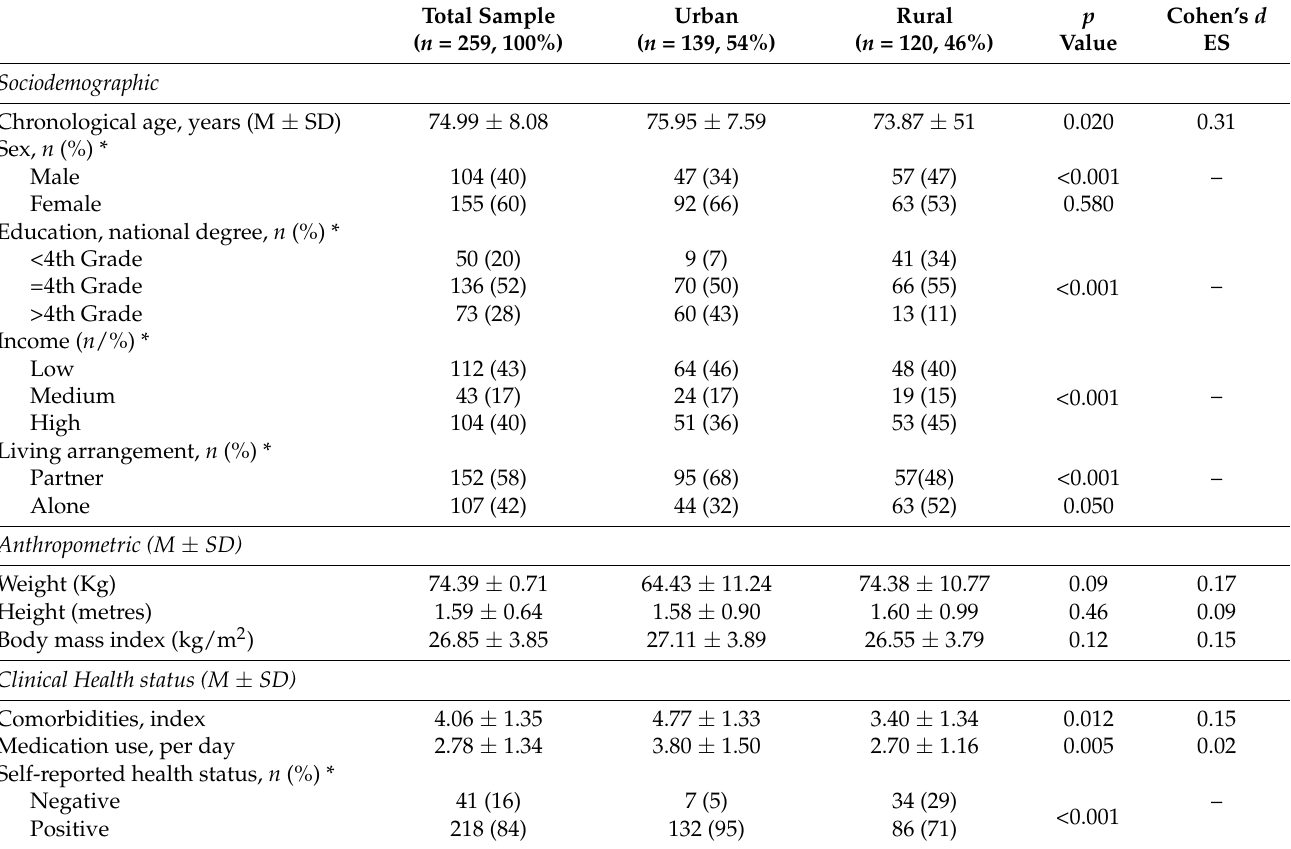
Table 1. Characterization of the sociodemographic, anthropometric, and clinical health parameters of the older adults living in urban and rural